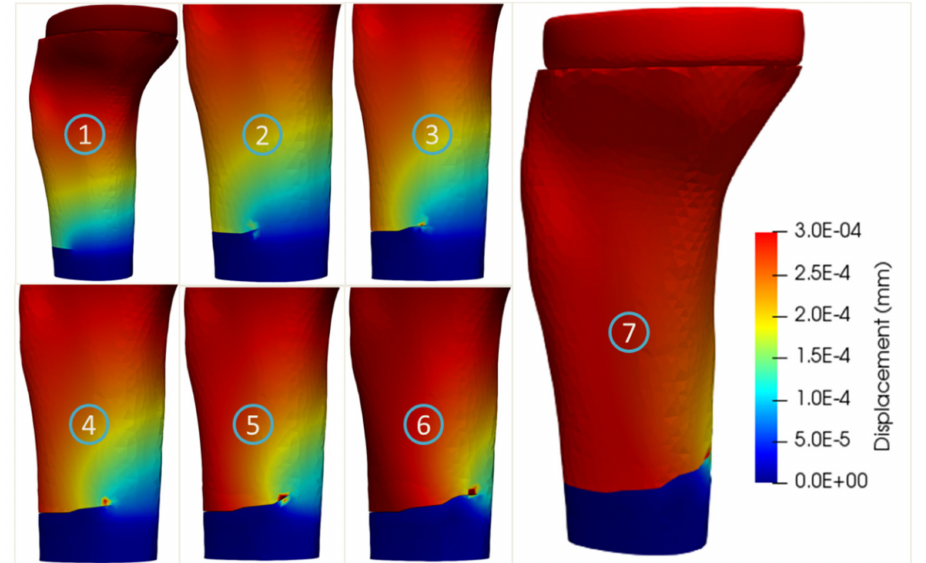
Figure 12. Crack propagation in the tibia bone model with implant of the 27-year-old female.